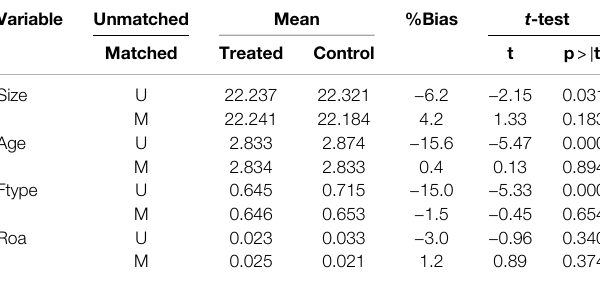
TABLE A1 | Balance test results of PSM